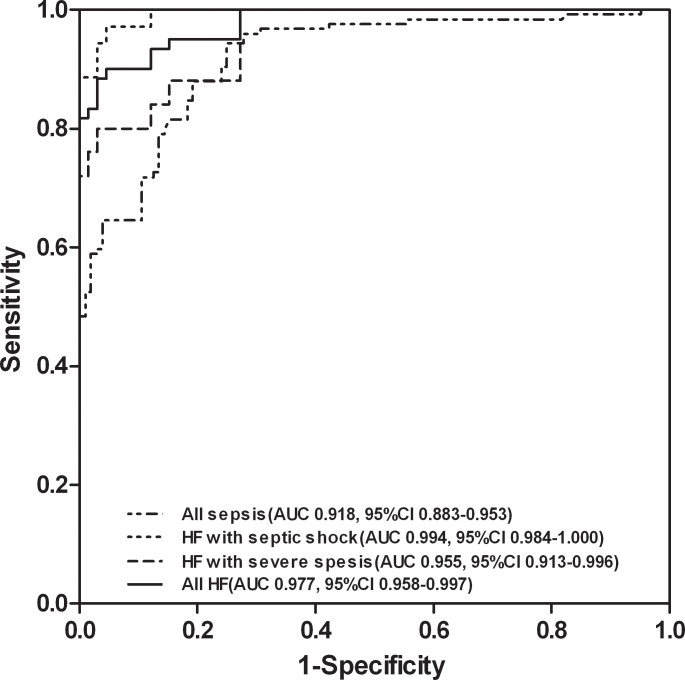
Comparing ROC curves for plasma NT-proBNP in all pediatric patients with sepsis, HF patients with severe sepsis, HF patients with septic shock, and all HF patients with sepsis.